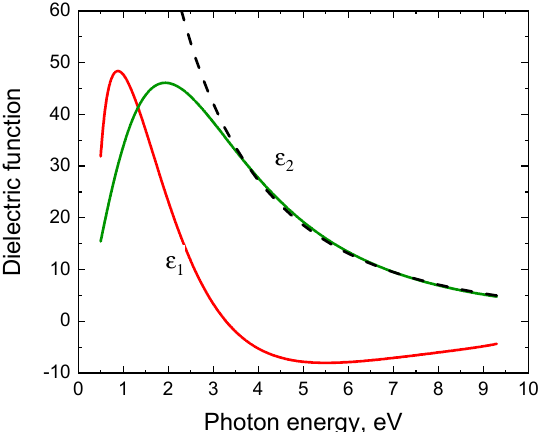
Figure 11. Dependence of the dielectric constant ( ε 1 is its real part, ε 2 is its imaginary part) of the interface layer of a semimetal on the photon energy, measured in the range of 0.5–9.3 eV by an ultraviolet ellipsometer J.A. Woollam VUV-VASE with a rotating analyzer on the assumption that the thickness of the semimetal interface layer is h 1 = 2 nm.